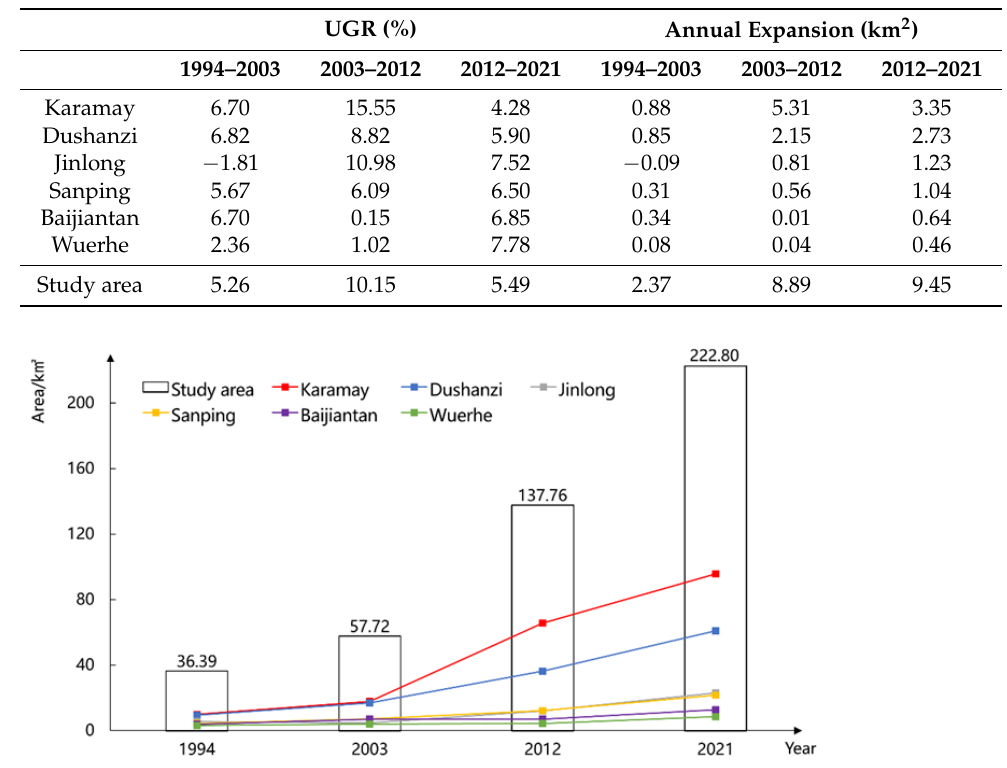
Table 2. Values of UGR.